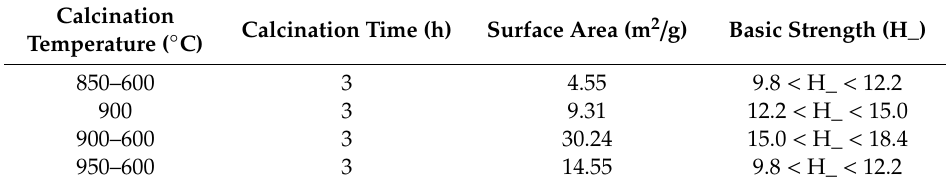
Table 2. Surface area and basic strength of the obtained CaO / PMFA catalysts.